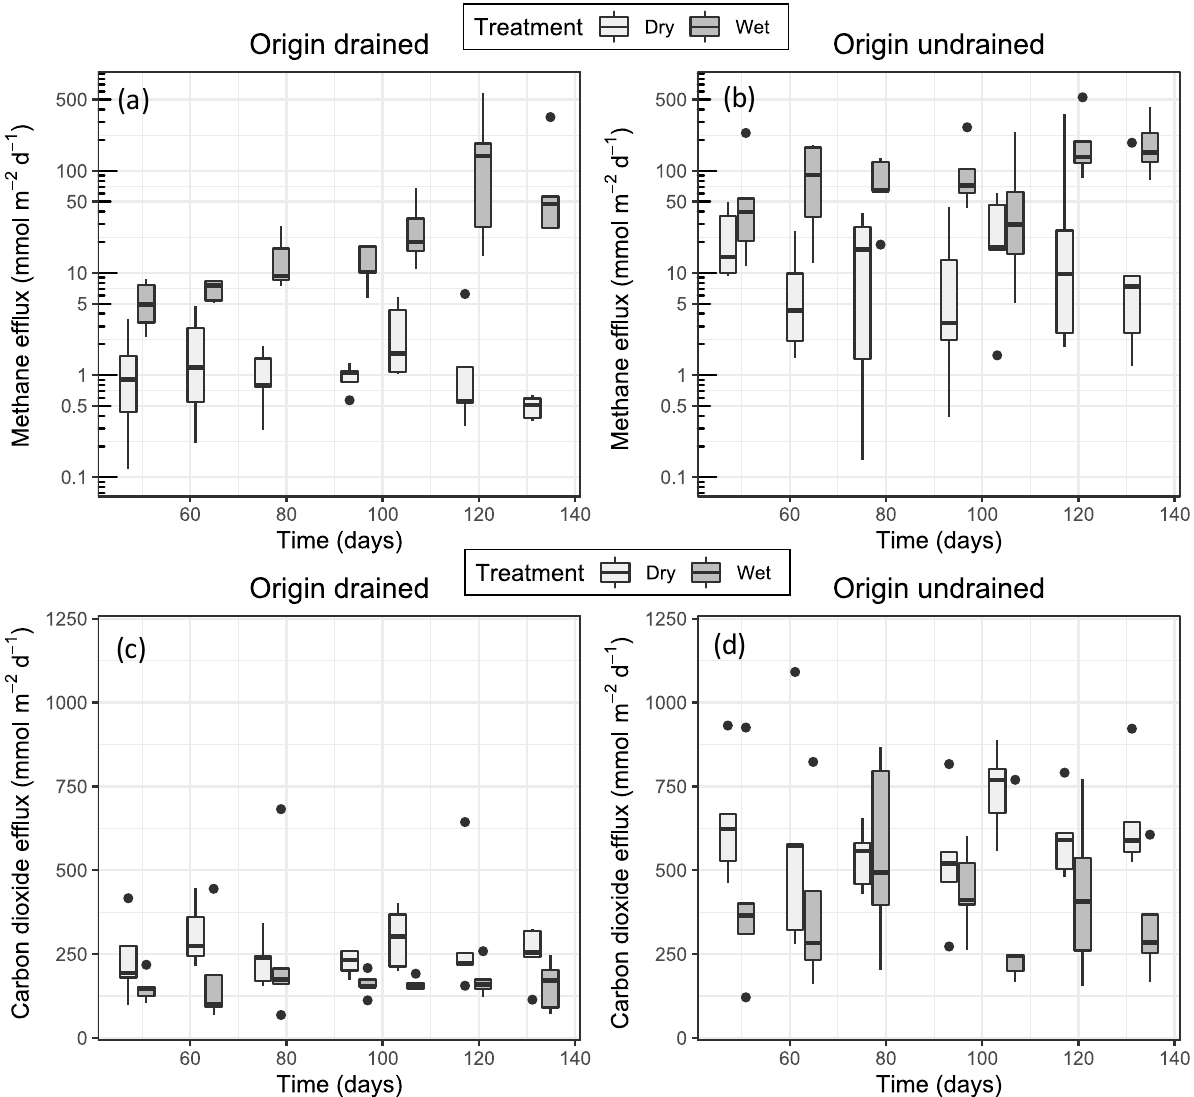
Figure 2. Emission rates of (a,b) CH 4 [log10 scale] and (c,d) CO 2 from unvegetated peat monoliths collected in two fen sites with different drainage histories (historically “drained” or “undrained”) over time and in response to two experimentally induced water levels (“wet” or “dry”, i.e. water levels at 0 cm and 15 cm below the peat